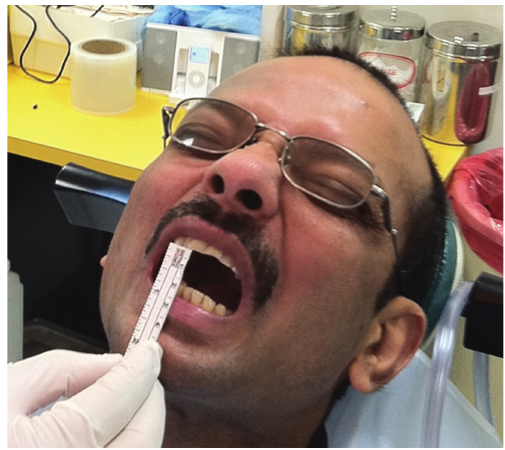
Figure 1: Preoperative view of the patient mouth opening.